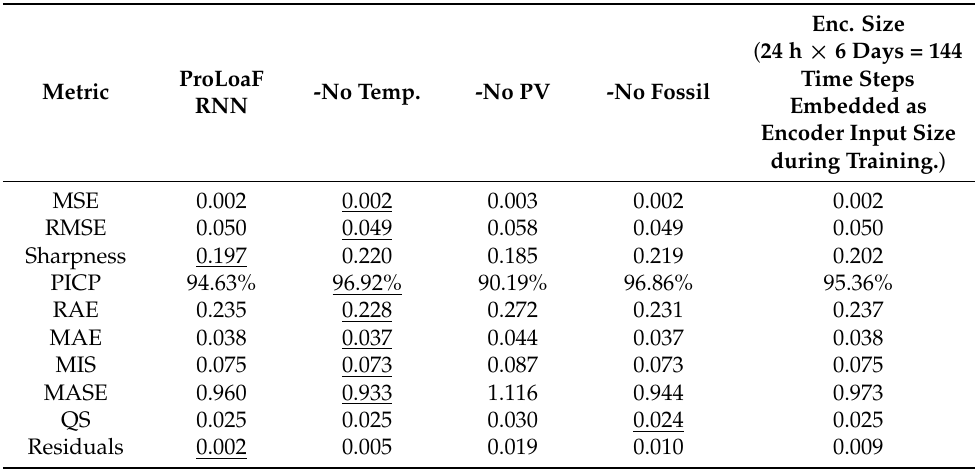
Table 8. Ablation results of presented ProLoaF RNN configuration. The underlined values indicate the best model in the analyzed metric